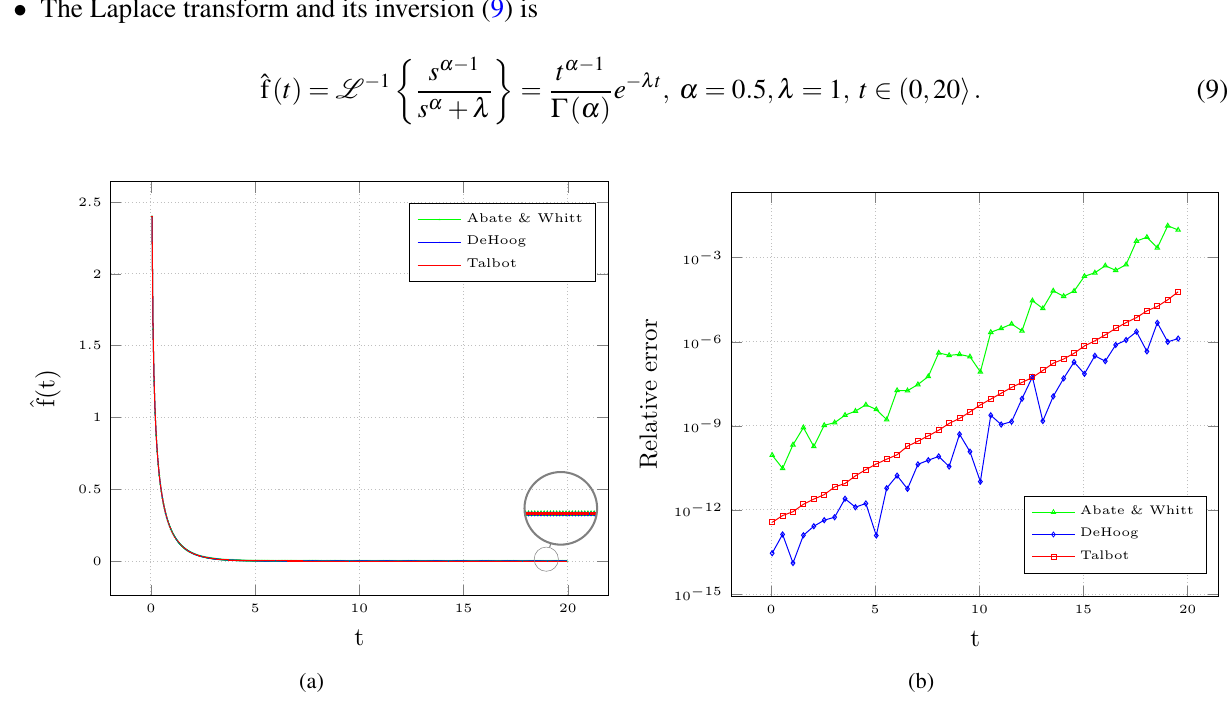
Fig. 9 Plots of numerical inversions ˆ f ( t ) of the Laplace transform (9) (a) and their relative errors (b) for applied methods in interval ( 0 , 30 (cid:105) .